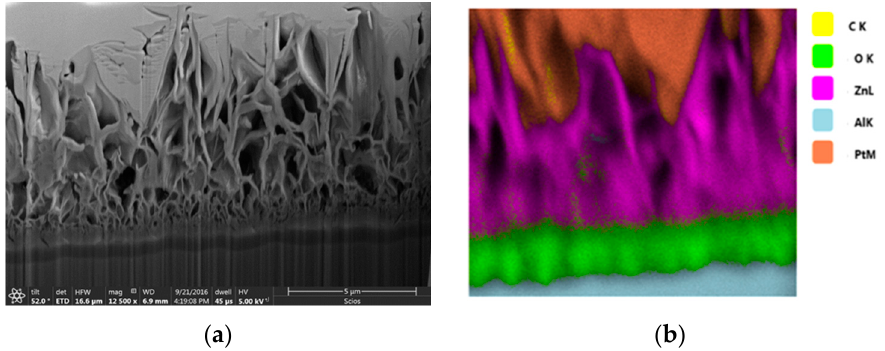
Figure 5. ( a ) SEM micrograph showing the cross-sectional cut made by FIB of the MIS-type structure; ( b ) Elemental mapping performed in each of the layers that form the MIS-type